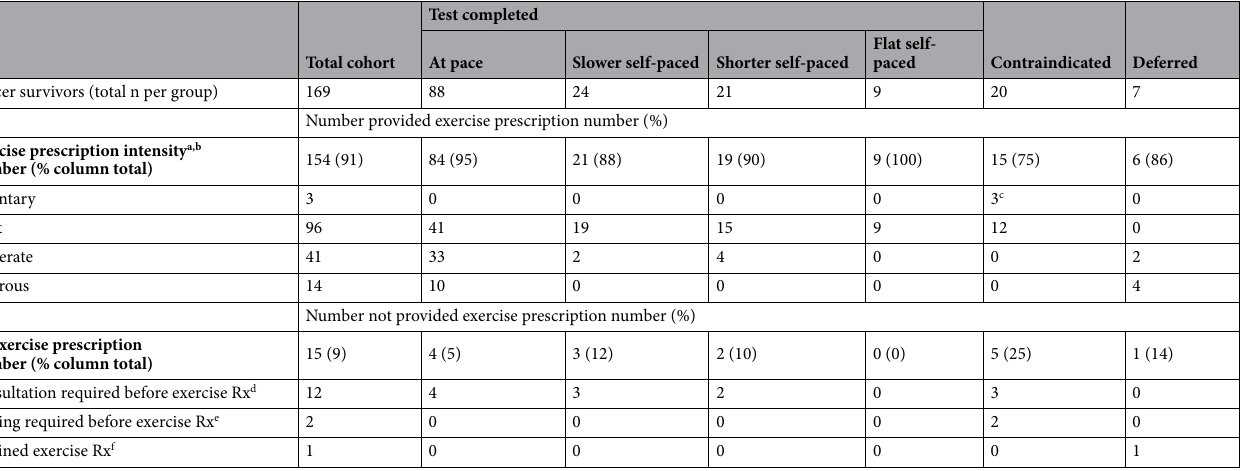
Table 7. Exercise prescription. SEM: standard error of the mean. a Exercise Rx: at pace vs. slower self- (Table 2) vs. exercise Rx: total cohort p = 0.0000, at pace p = 0.0000, chi square, two-tailed. slower self-paced p = 0.0001, shorter self-paced p = 0.0002, contraindicated p = 0.0003, Fisher’s exact, two-tailed. c N = 1 balance exercises. N = 1 range of motion exercises. N = 1 activities of daily living only. d N = 8 cardiac stress test, N =